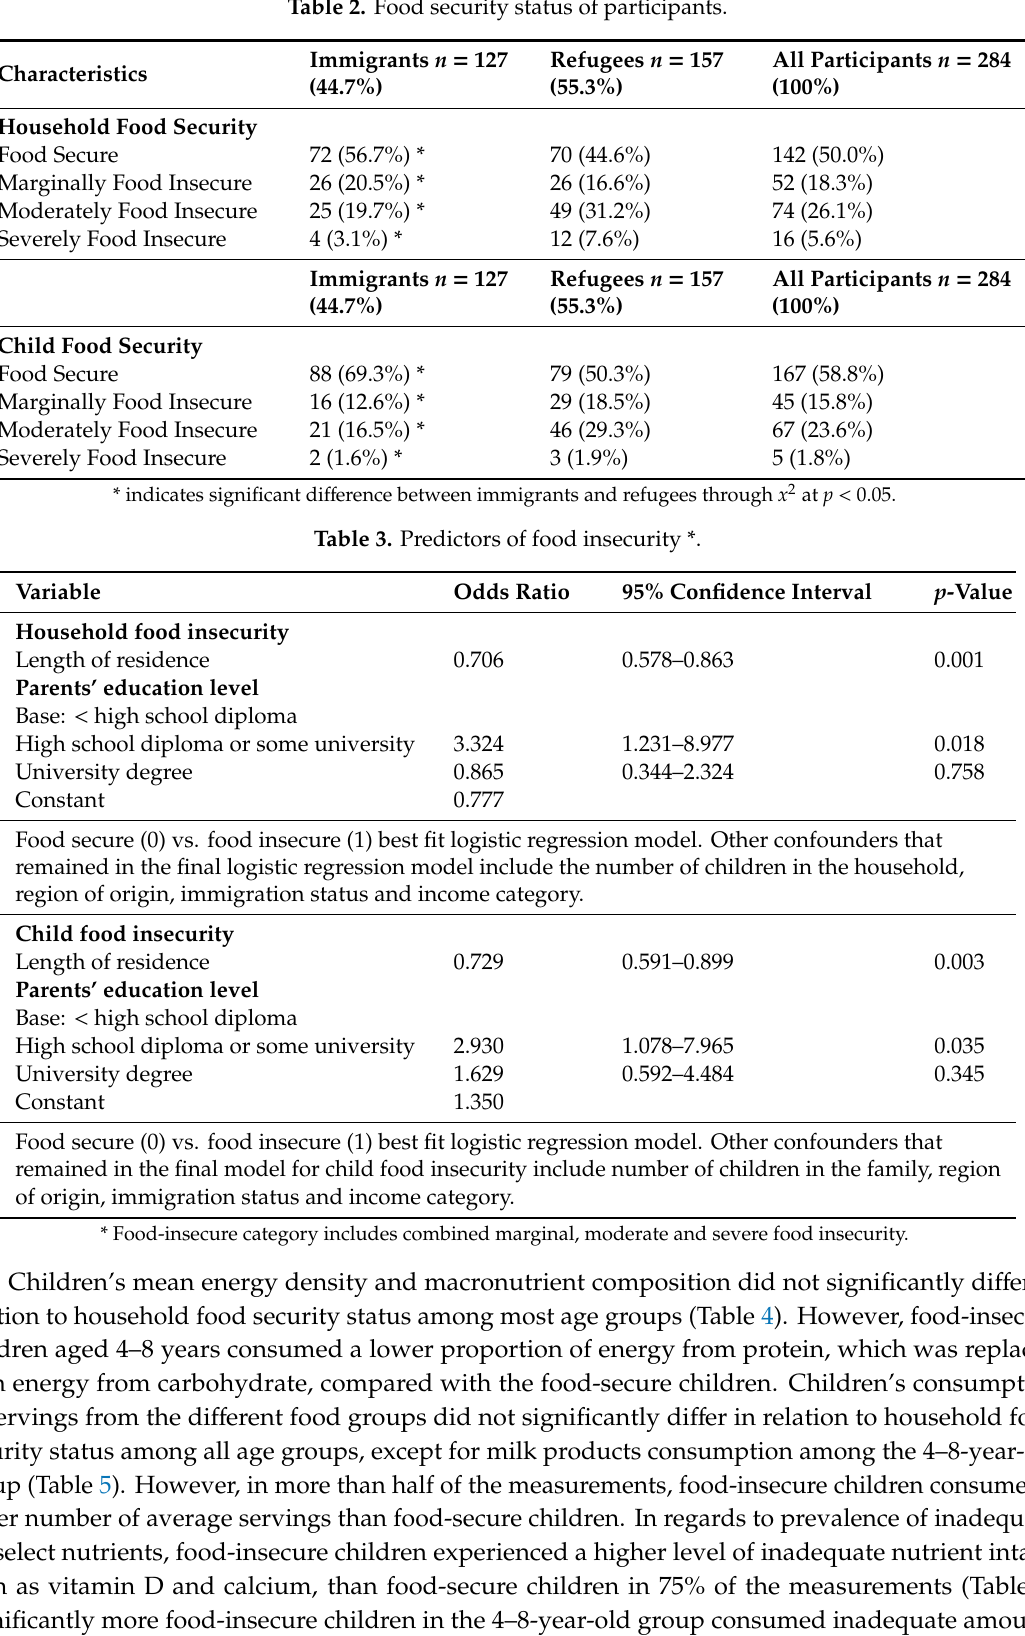
Table 2. Food security status of participants.